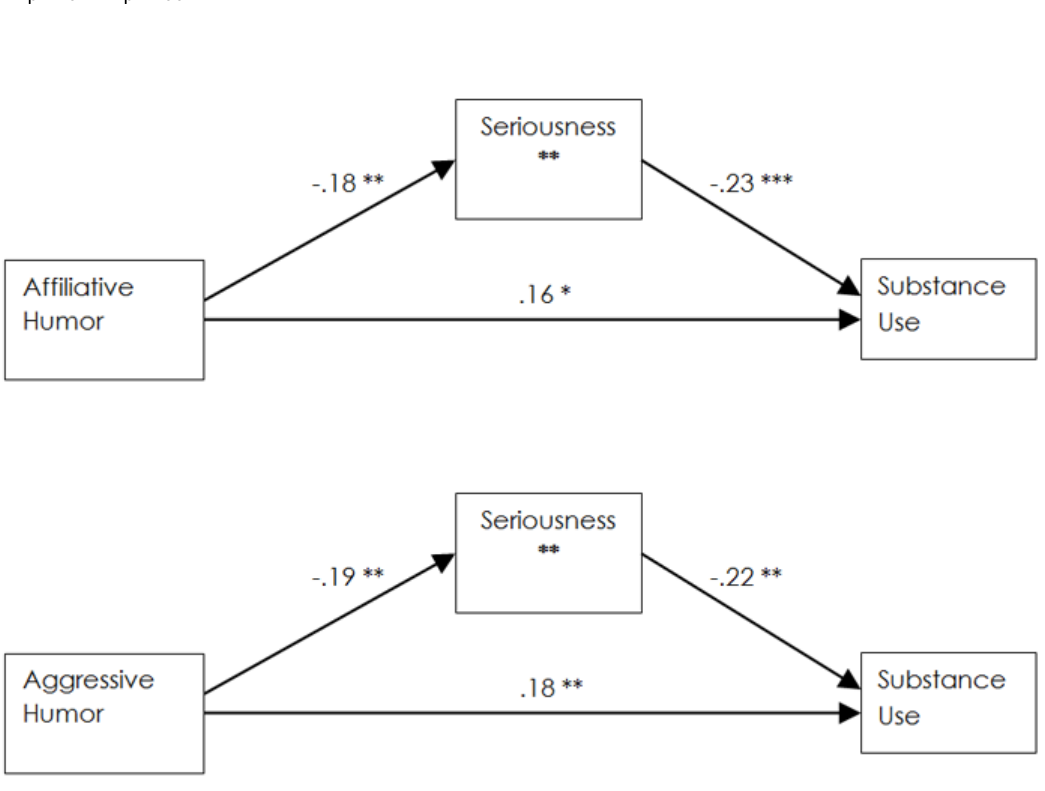
Figure 1. Mediating effect of seriousness on relationships between affiliative as well as aggressive humor and substance use. Note . *p < .05. **p < .01. ***p <